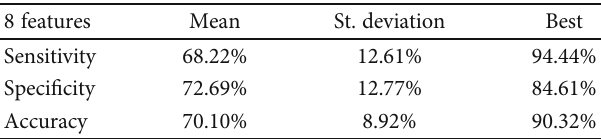
Table 9: Results for Logistic Regression with the selected 8 features.